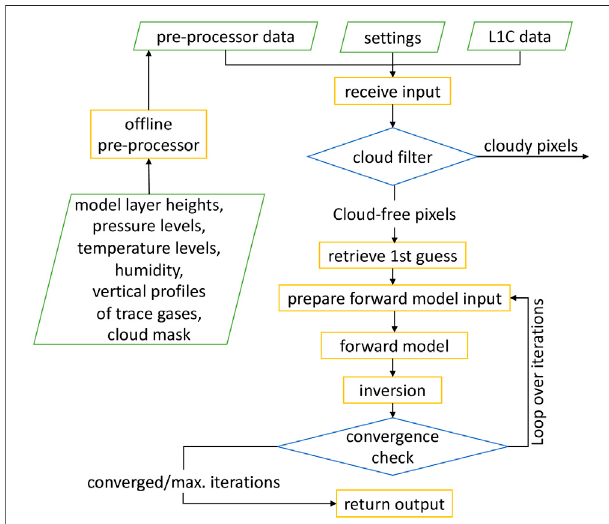
FIGURE 1 | Flowchart of the full-physics retrieval